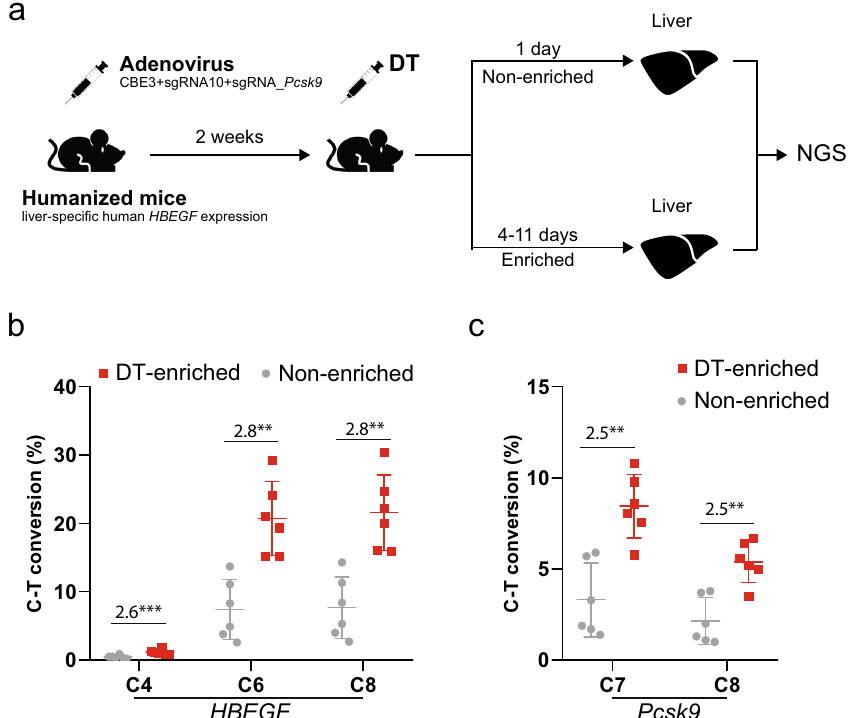
Fig. 7 Co-selection of base editing events in vivo in mice with humanized liver. a Design of an in vivo co-selection experiment. Adenovirus was used to introduce CBE3, sgRNA10, and a sgRNA targeting Pcsk9 . After 2 weeks, mice were dosed with DT and terminated at 24 h or 4 – 11 days. At termination, liver tissue was collected for genomic DNA extraction and analysis by NGS. Icons of mice and syringes were created in a previous publication 84 , and were used without modi fi cation under Creative Commons Attribution 4.0 International License (http://creativecommons.org/licenses/by/4.0/). b Enrichment of CBE editing at the HBEGF locus. c Co-selection of the CBE editing events at the Pcsk9 locus. The presented values and error bars present mean ± s.d. of n = 6 independent biological replicates. The relative fold change values are indicated in the graphs. * P < 0.05, ** P < 0.01, Student ’ s paired t test (two-tailed). P values are calculated as below: in b , HBEGF (C4 = 0.0007, C6 = 0.0022, and C8 = 0.0017); in c , Pcsk9 (C4 = 0.0100 and C6 = 0.0099). Source data of Fig. 7b, c are provided as a Source data fi